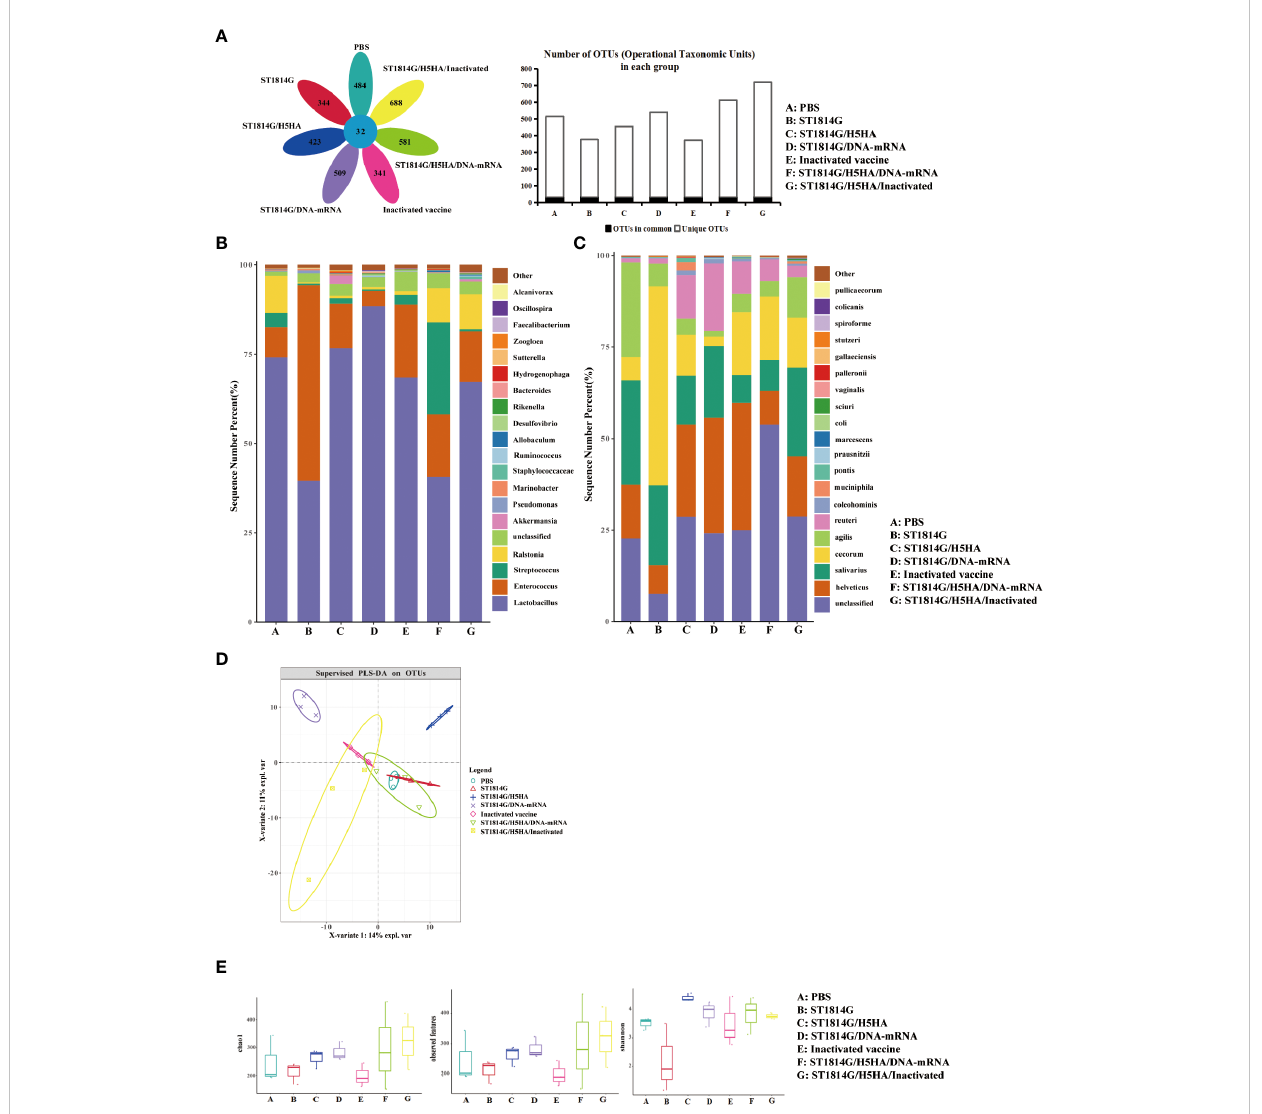
FIGURE 4 Effect of vaccines on intestinal micro fl ora diversity post immunization. (A) Venn diagrams (left) and bar charts (right) of common or endemic species. (B) Relative content of bacterial genus in each group. (C) Relative content of bacterial species in each group. (D) Partial least-squares discrimination analysis (PLS-DA) revealed the diversity of chicken gut microbiota among the seven groups. Dots represent individual samples. (E) The analysis of Alpha diversity index, Chao1, Shannon and observed features, showed the diversity of chicken gut microbiota within each group post immunization. Dots represent individual